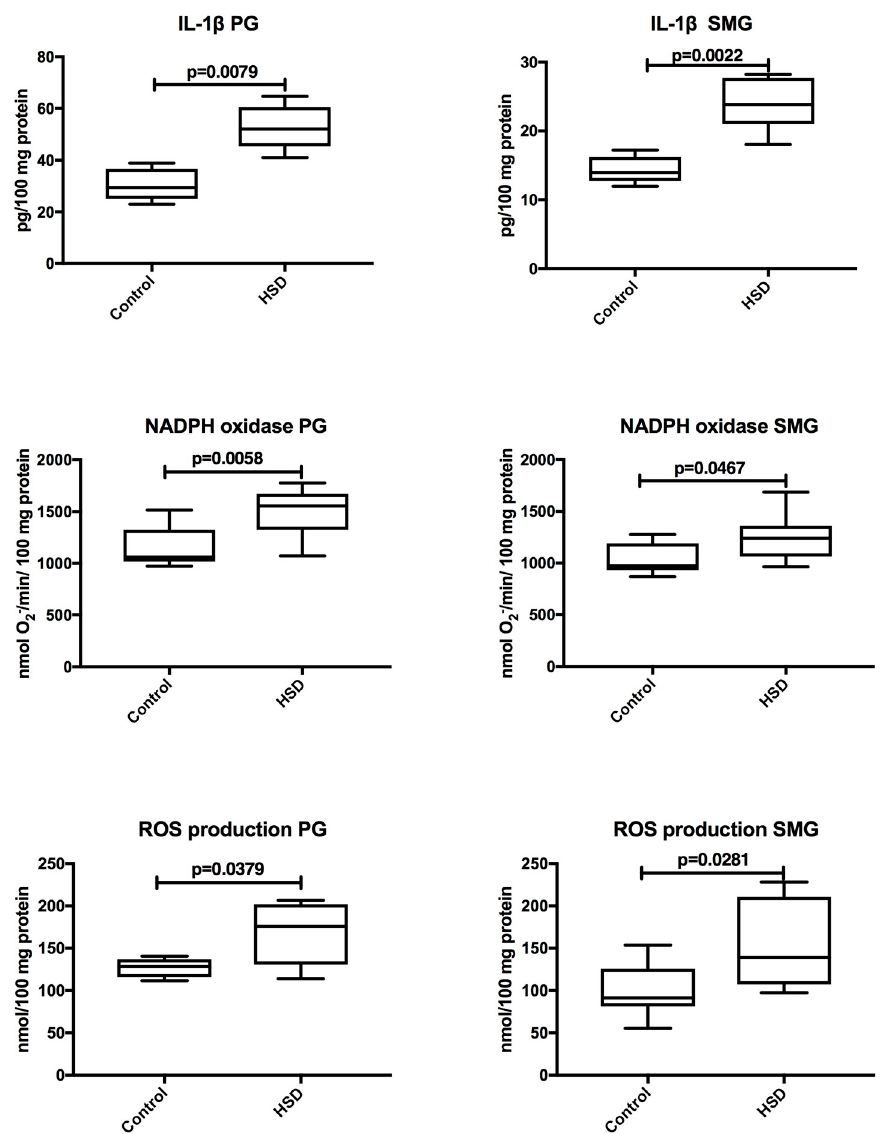
Figure 8. The effect of a high-sucrose diet (HSD) on salivary glands inflammation and reactive oxygen species (ROS) production. Abbreviations: IL-1 β , interleukin-1 β , PG, parotid glands, SMG, submandibular glands.